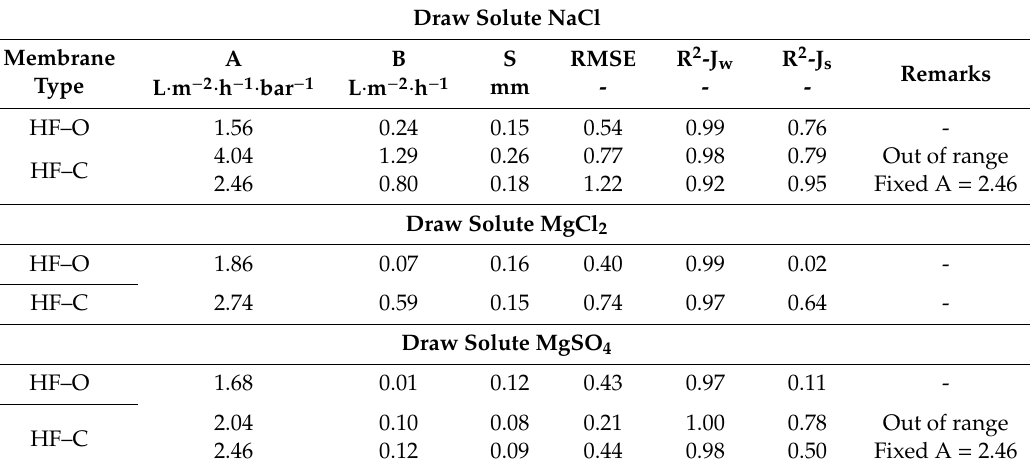
Table 6. Parameters A, B, and S estimated for NaCl, MgCl 2 , and MgSO 4 draw solute systems. RMSE and R 2 represent the root mean square error and the coe ffi cient of determination, respectively, for the model. J w , water flux; J s , reverse solute